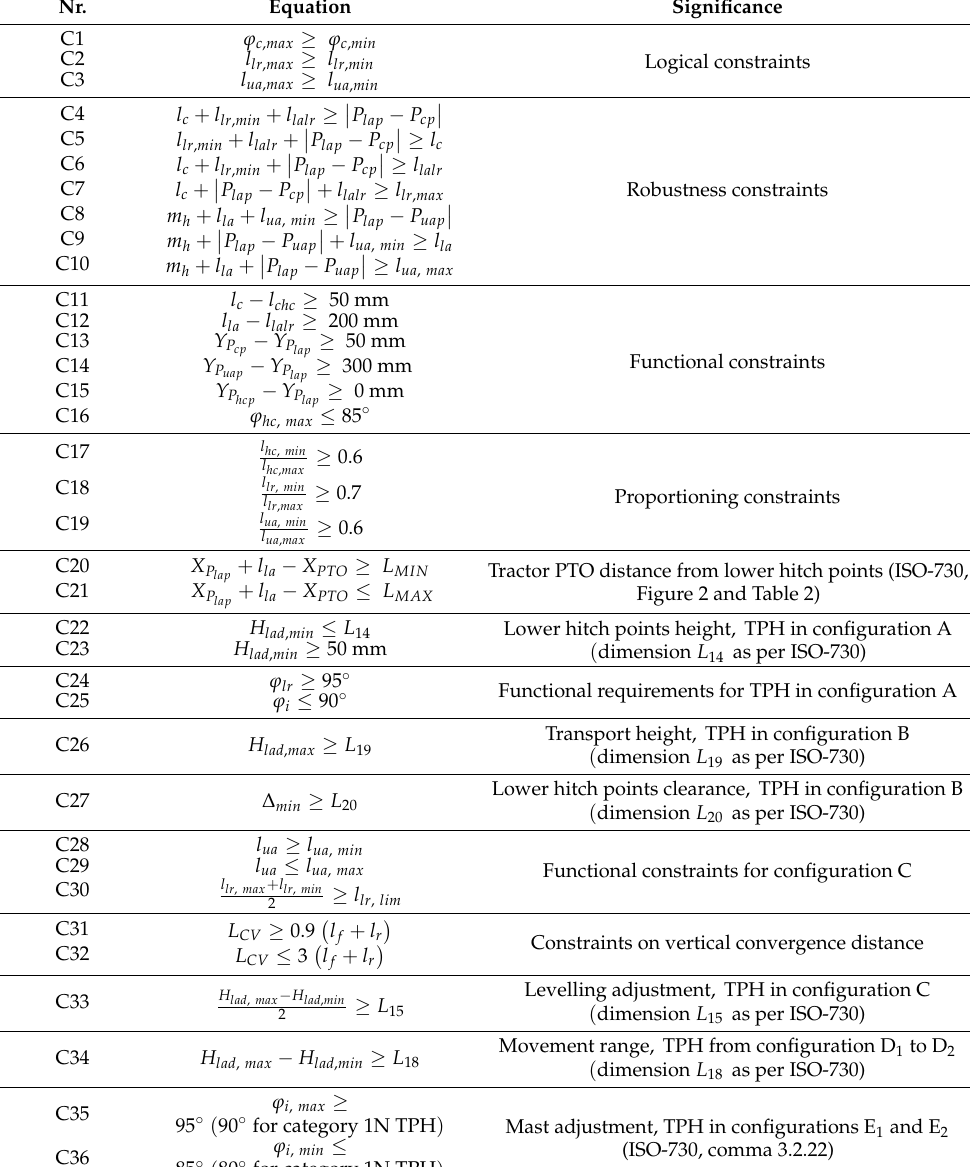
Table 1. Optimiser constraints.